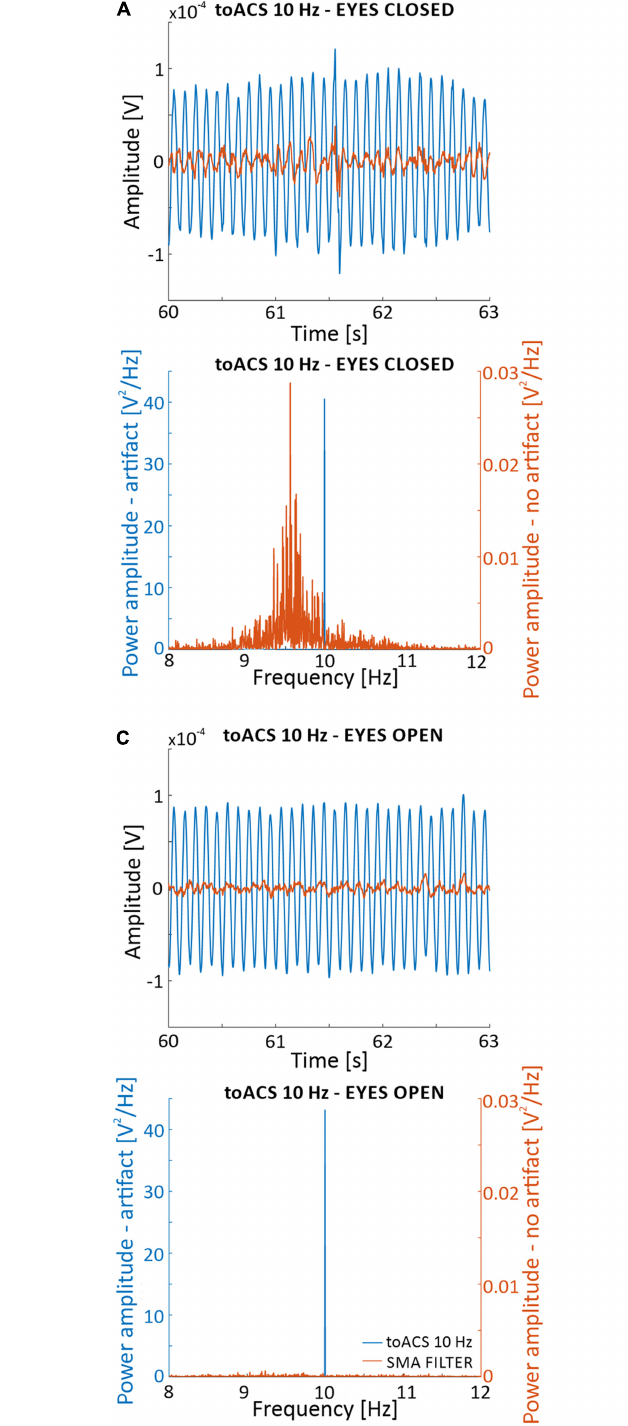
Frontiers in Neuroscience |